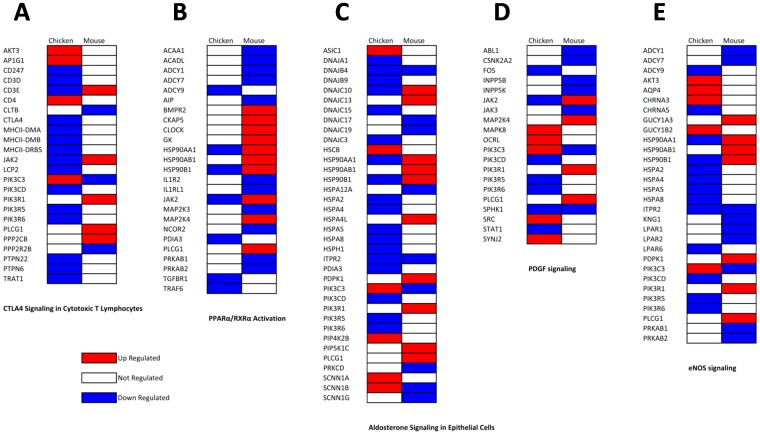
Heat maps of selected genes showing differential regulation in response to PB1-F2 in lungs of chicken and mouse at day 2 pi.Genes are representative of “CTLA4 Signaling in Cytotoxic T Lymphocytes” (A), “PPARα/RXRα Activation” (B), “Aldosterone Signaling” (C), “PDGF Signaling” (D) and “eNOS signaling” (E). Genes shown in red are up-regulated and those shown in blue are down-regulated in presence of PB1-F2.